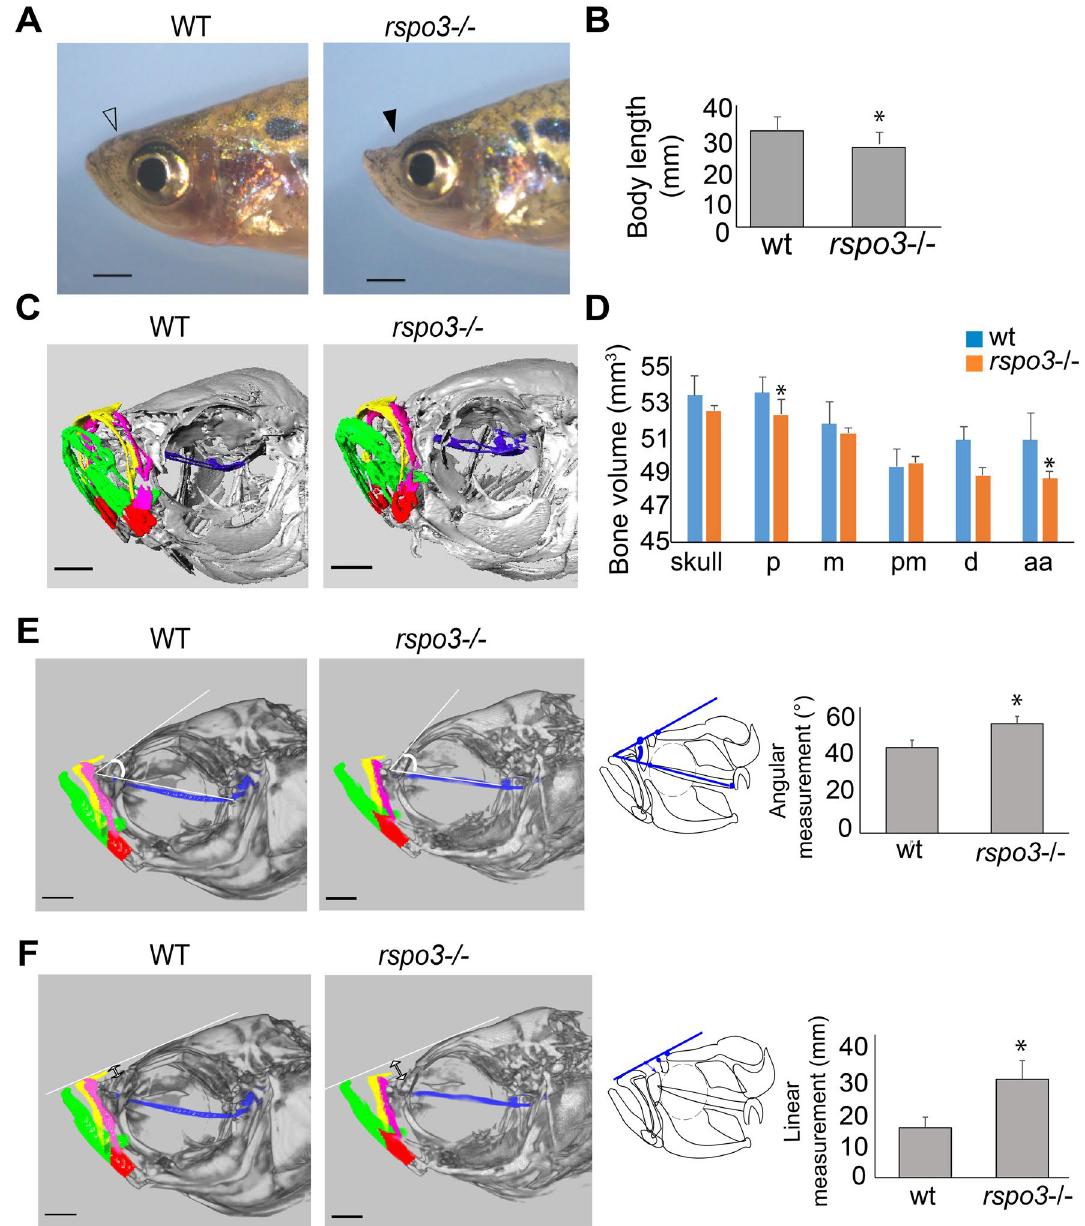
Figure 7. rspo3 mutants exhibited midface deficiency, frontal bossing and decreased body length. Reduced body length, midface deficiency and frontal bossing were observed in adult rspo3 −/− (180 dpf). ( A ) Lateral image of adult zebrafish showing midface depression in rspo3 −/− (solid arrow) compared to wild-type (open arrow). ( B ) Body length was significantly decreased in rspo3 −/− mutants relative to wild-type. ( C ) Oblique micro-CT image of rspo3 −/− and wild-type fish at 180 dpf. Individual bone elements are color coded (blue: parashenoid, pink: maxilla, yellow: premaxilla, green: dentary and red: anguloarticular). Scale bar: 10 μm. ( D ) Bone volume of the skull and of specific bones in rspo3 −/− and wild-type individuals demonstrates element-specific differences in volume. Parasphenoid and anguloarticular bone volume were significantly reduced in rspo3 −/− compared to wild-type fish. Abbreviations: aa: anguloarticular, d: dentary, m: maxilla, p: parasphenoid, pm: premaxilla. ( E ) 2D cephalometric analysis obtained from micro-CT of rspo3 −/− and wild-type fish. The angle formed by parasphenoid line and a line tangent to frontal bone identified frontal bossing, with increased angle in rspo3 −/− compared to wild-type. Diagram of lateral view of adult zebrafish showing the angular measurement. Bar chart showing statistical differences in the angular measurement between rspo3 −/− and wild-type. ( F ) 2D cephalometric analysis of rspo3 −/− and wild-type fish. The distance between nasal bone and a line drawn between dentary and frontal bone landmarks were measured. Diagram of lateral view of adult zebrafish showing the linear measurement from nasal bone to a line tangent to the frontal bone and dentary. The linear measurement value was significantly greater in rspo3 −/− mutants than in wild-type indicating the presence of midface hypoplasia. *p ≤ 0.05 . Scale bar: 100